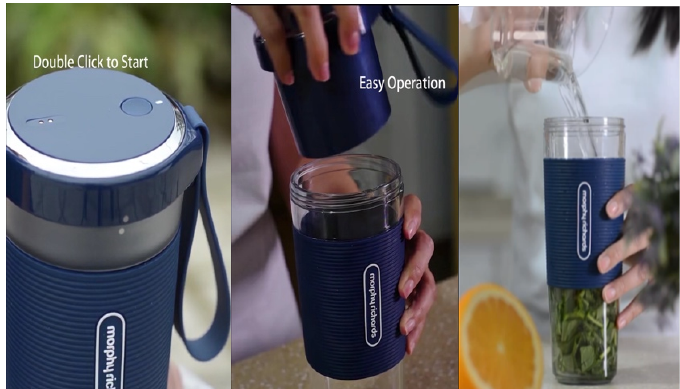
Figure 7. The example of using product tutorial information.